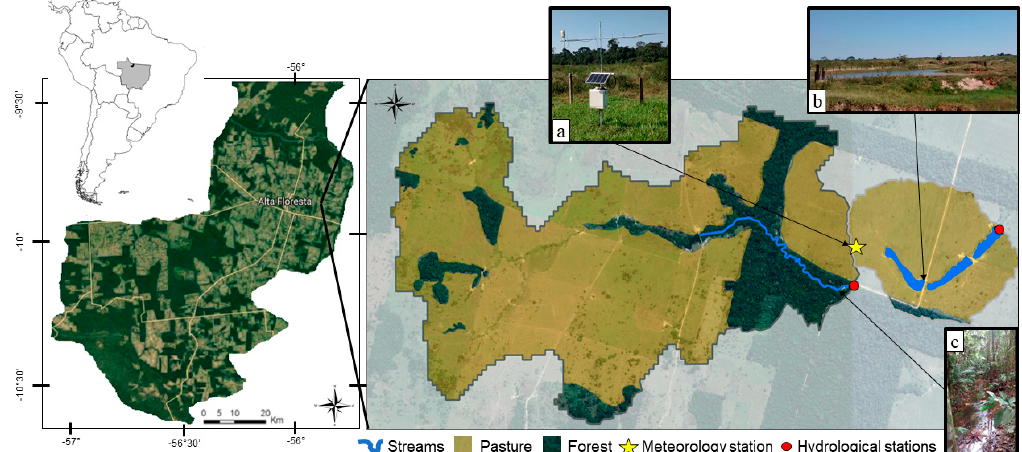
Figure 1. The location of the Pedra Alta ranch in Alta Floresta, Mato Grosso, Brazil, in Southern Amazonia with the location of the micrometeorological station (yellow star ( a )) and the two studied headwater pasture catchments (Dam ( b ), and Forest ( c )). Water samples were collected and discharge recorded at locations indicated by red circles.